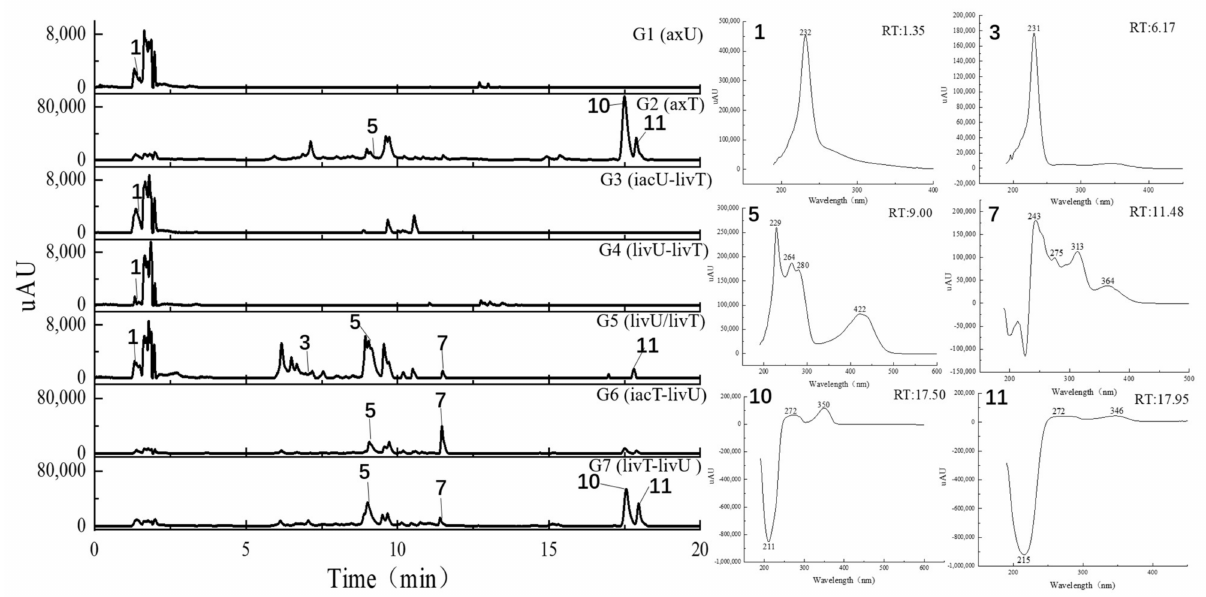
Figure 5. The HPLC traces of the culture extracts detected under the UV wavelength of 360–370 nm and the UV spectra for the featured peaks. The samples include axU (G1), axT (G2), iacU-livT (G3), livU-livT (G4), livU/livT (G5), iacT-livU (G6), and livT-livU (G7). The numbers marked on the peaks or in the UV spectra are numbers for the peaks with remarkable yield changes detected by mass spectrometry and are consistent with the peak numbers in Table 2.